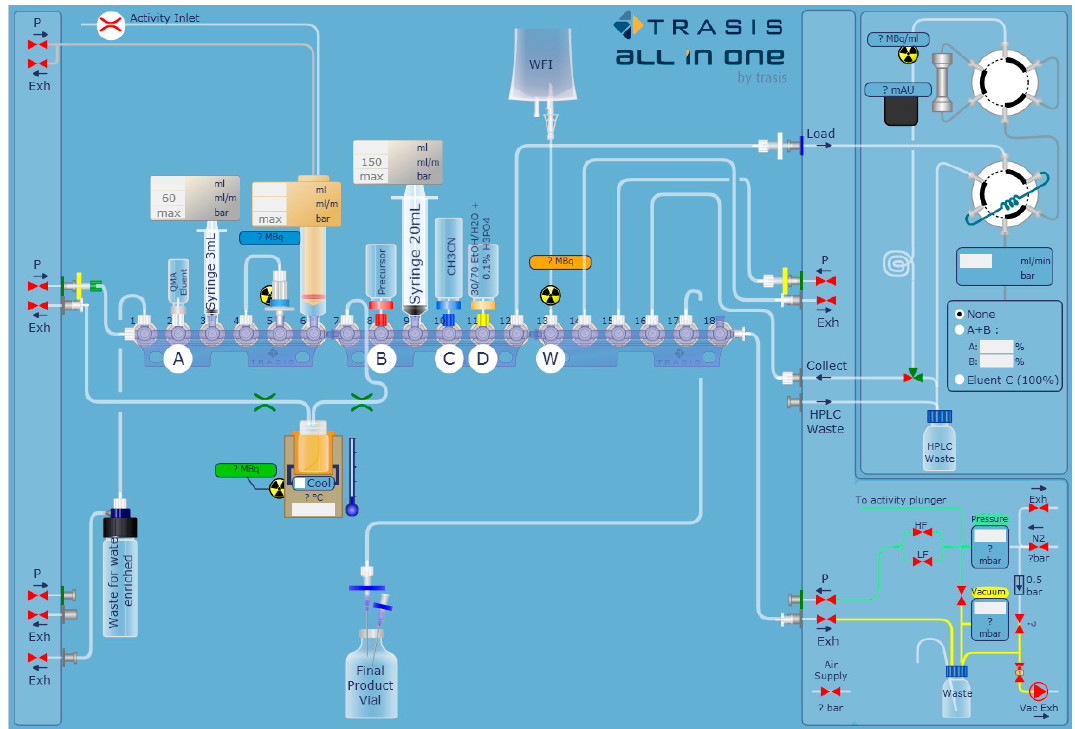
Figure 8. [ 18 F]FEPPA radiosynthesis layout on an AllInOne ® module.